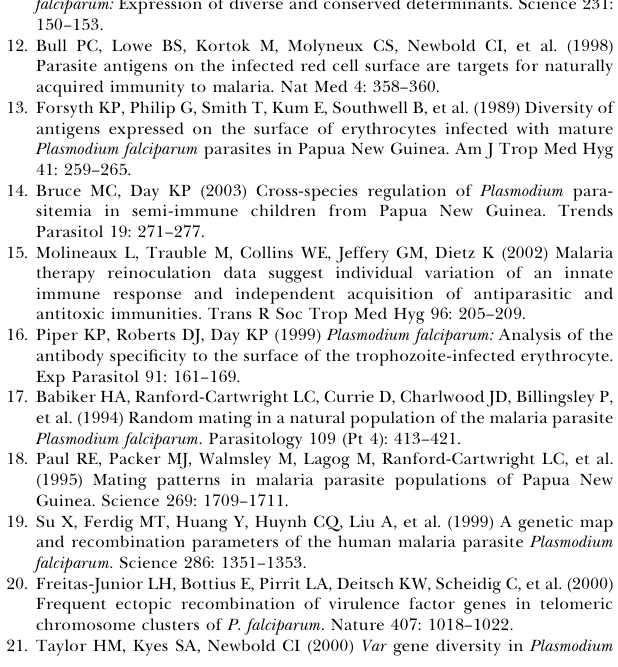
Figure S7. Prediction of var Gene Structural Groups within the Amele Population